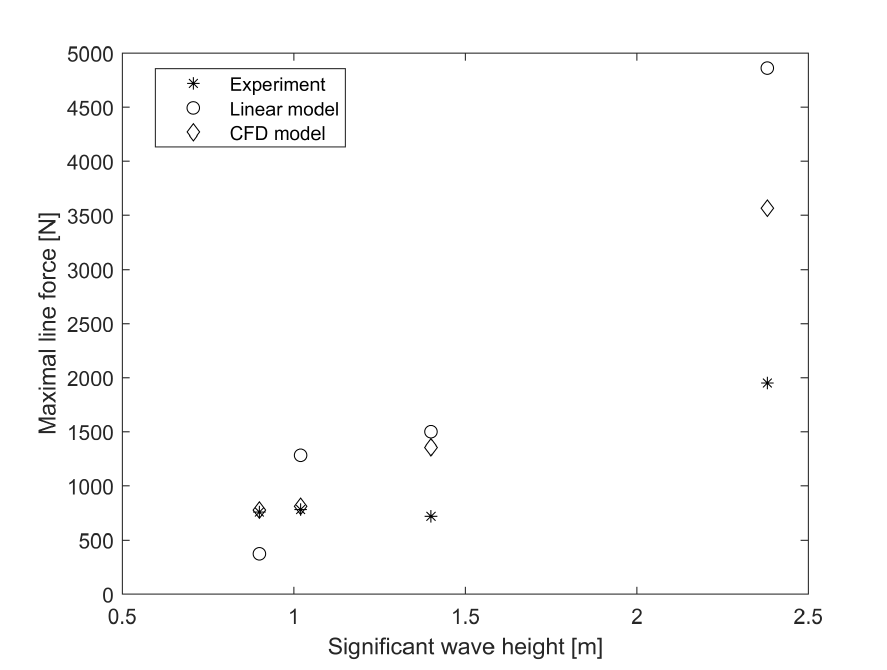
Figure 13. Comparison between predictions from the approximate linear model, the high-fidelity CFD model, and experimental data, for all sea states given in Table